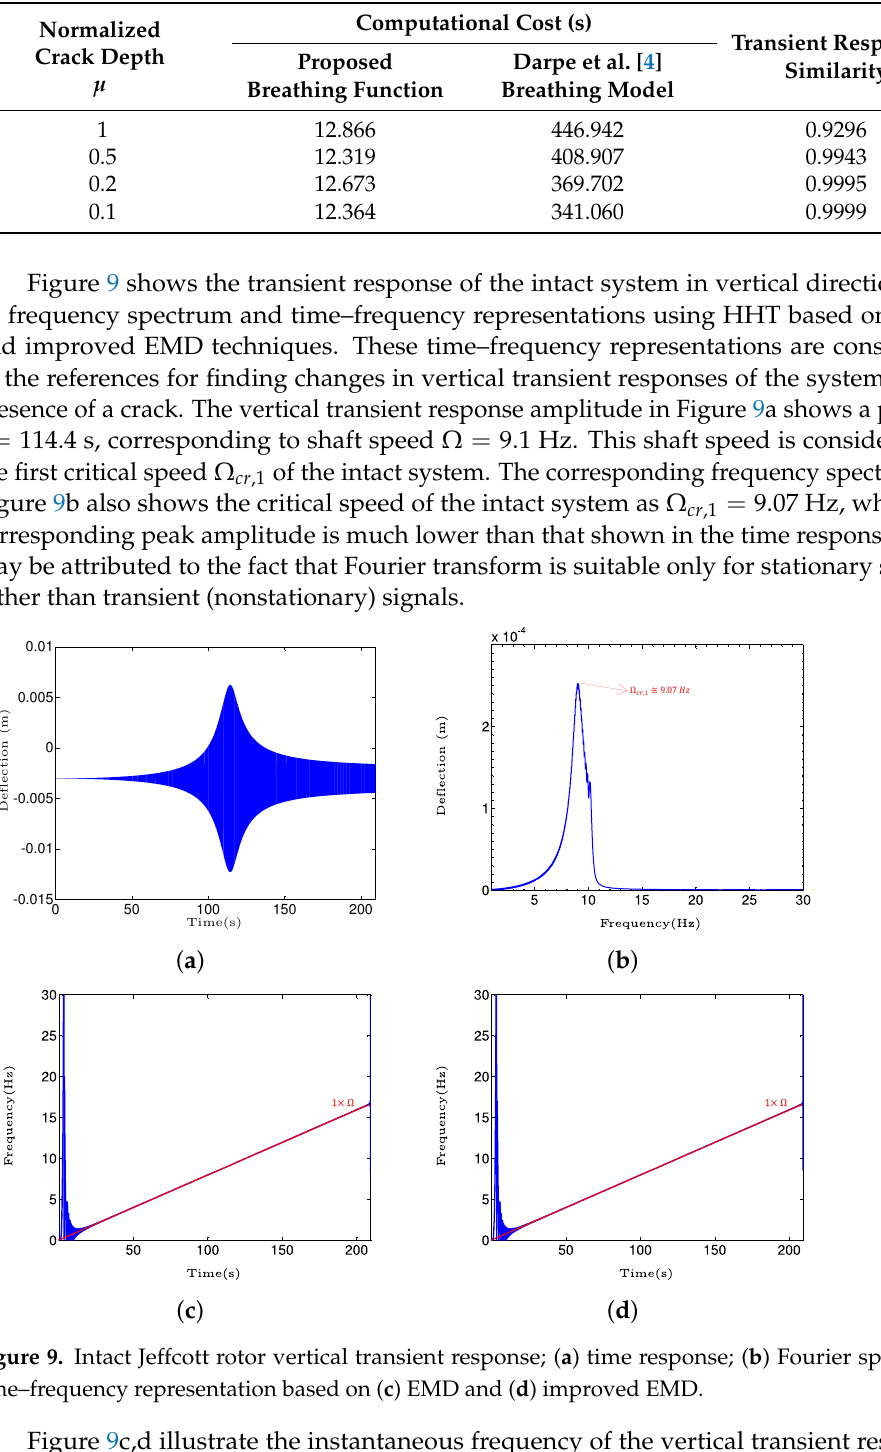
Table 2. Transient responses deviations and their computational costs with different normalized crack depths µ using the Darpe et al. [4] breathing model and proposed breathing function